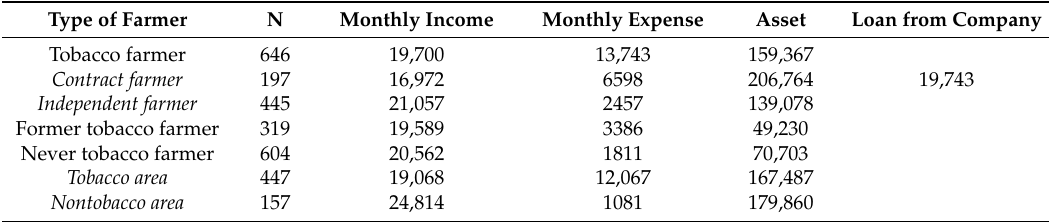
Table 5. Household income, expenses and asset (BDT) by farmer type.